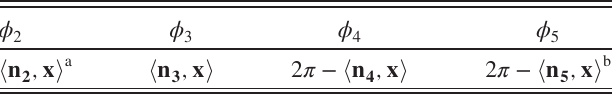
TABLE IV. Angles ϕ 2 ∼ ϕ 5 for calculating the straight parts.